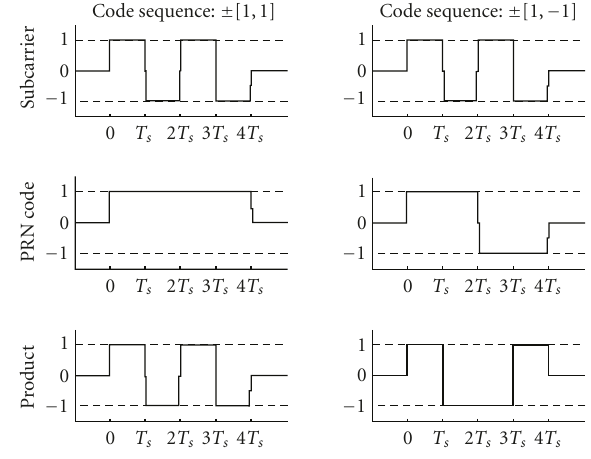
Figure 1: Product of BOC(1,1) subcarrier and spreading code for two code